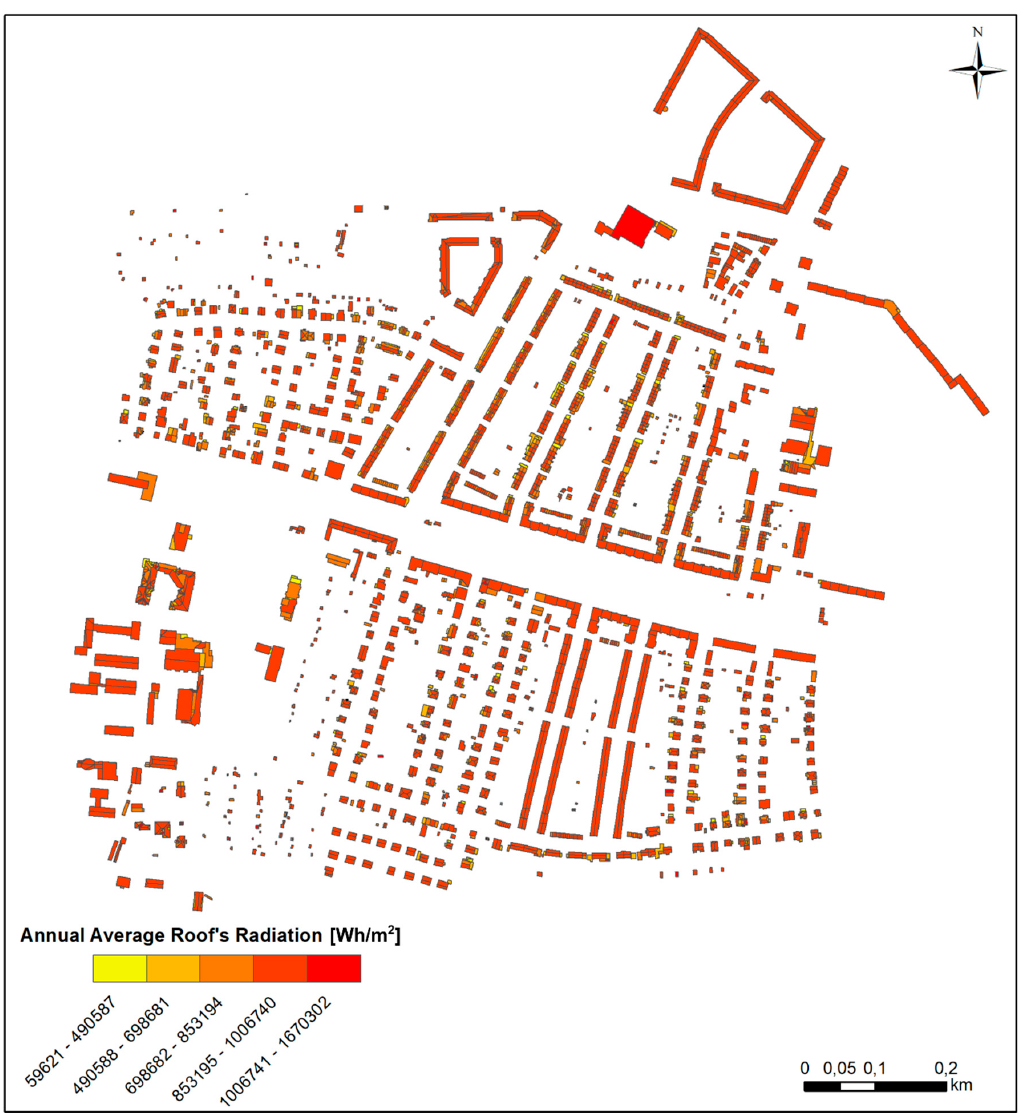
Figure 4. The results of the SOLIS assessment—sample A.